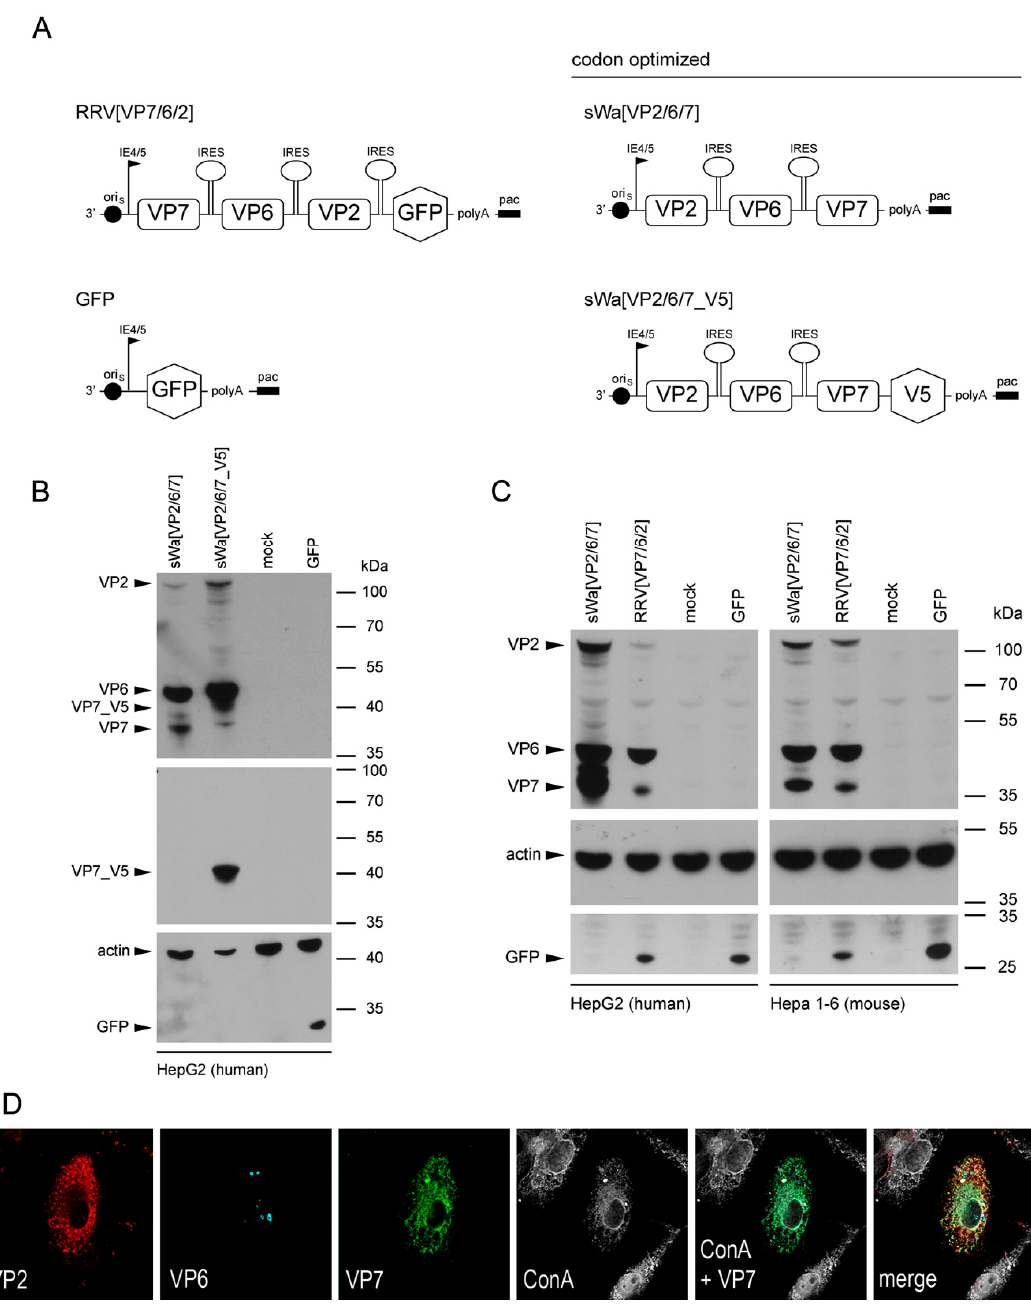
Figure 1. Rotavirus (RV) protein synthesis upon herpes simplex virus type-1 (HSV-1) amplicon vector transduction. ( A ) Schematic representation of the polycistronic gene expression cassettes